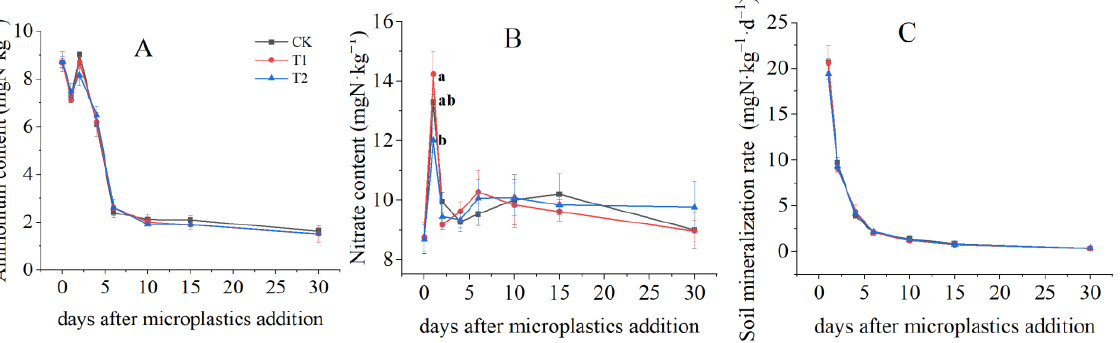
Figure 1. Temporal variations of soil NH 4+ ( A ), NO 3 − ( B ) contents and net mineralization rate ( C ). Letters designate significant differences among treatments ( p < 0.05).